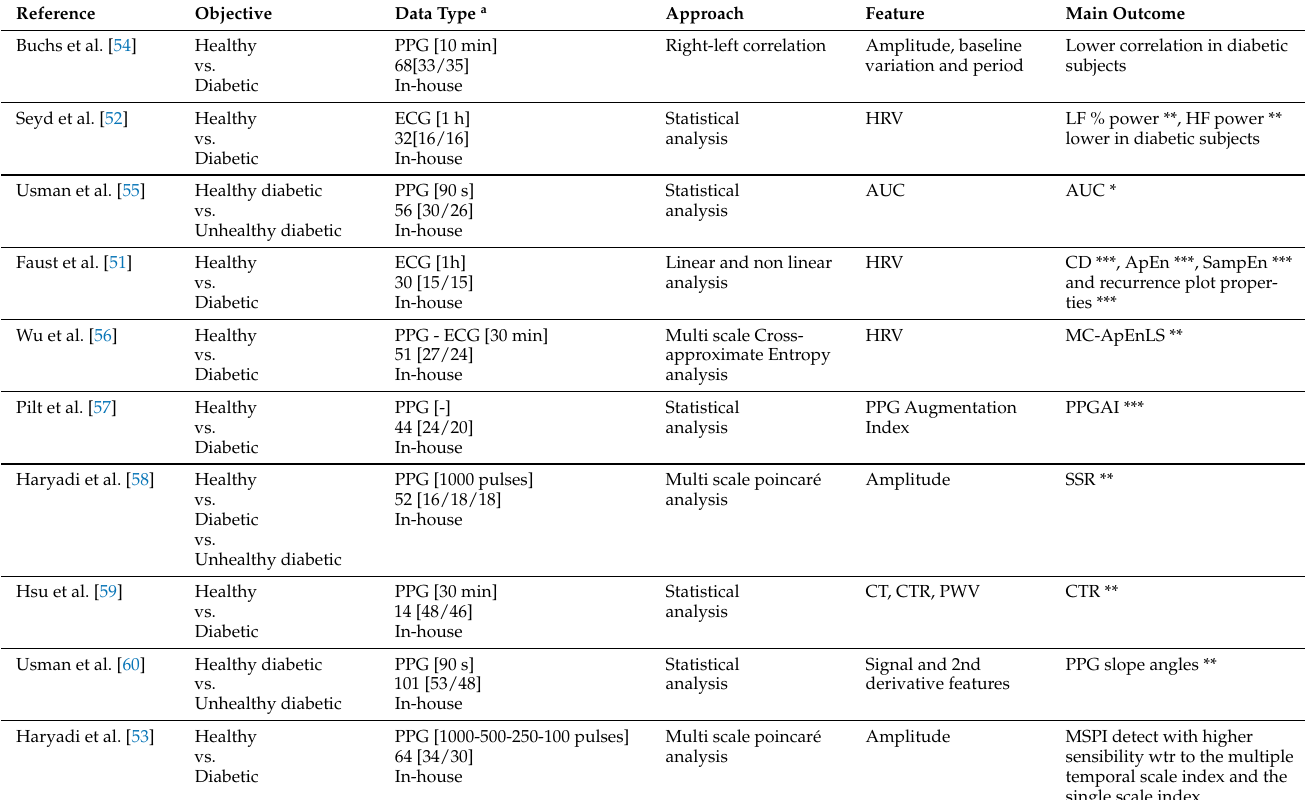
Table 2. Traditional methods for diabetes detection.